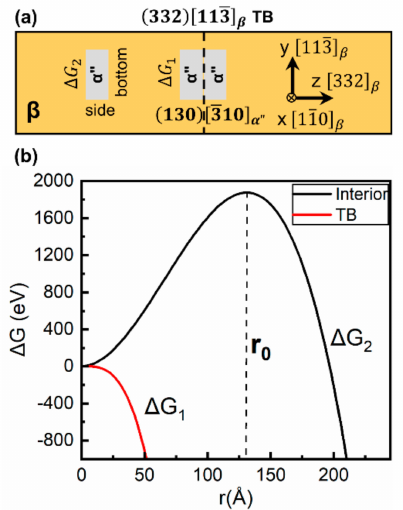
Figure 6. The kinetic behaviors of α ” formation at the TB and in β grain interior. ( a ) The schematic of the di ff erent nucleation sites for α ” phase at { 332 }(cid:104) 113 (cid:105) β TB and in β grain interior. ( b ) The driving energy curves associated with the formation of α ” phase at { 332 }(cid:104) 113 (cid:105) β TB and in β grain